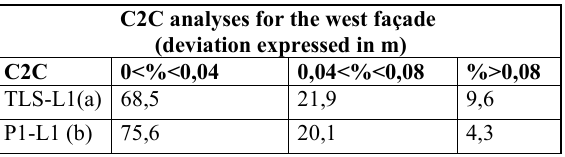
Table 5. C2C analyses of the west facade. For each dataset values are reported as percentages in a selection of ranges.